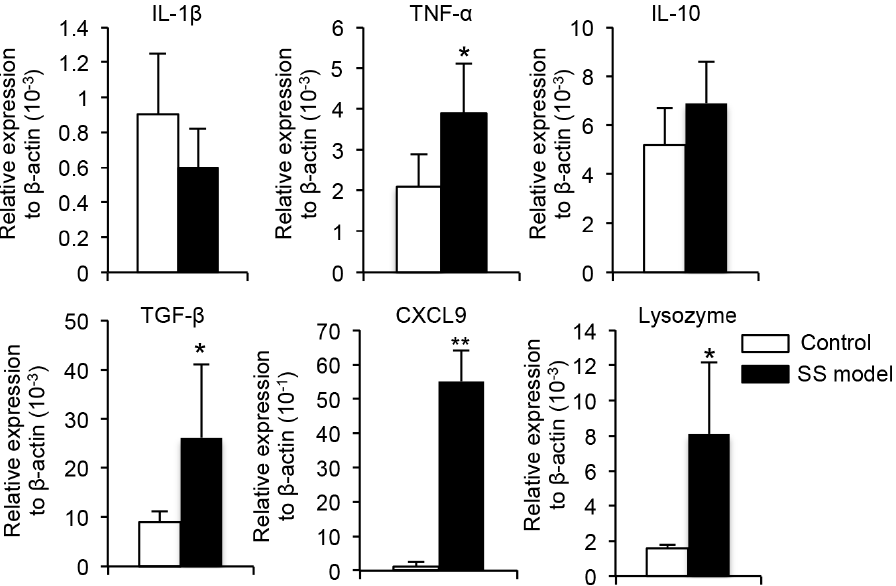
Figure 6. Gene expressions were assayed by RT-PCR. Expression of IL-1 β , TNF- α , IL-10 , TGF- β , CXCL9 , and lysozyme mRNA is shown. Data are average RNA levels ± SD of five mice in each group. * p < 0.05, ** p < 0.005.